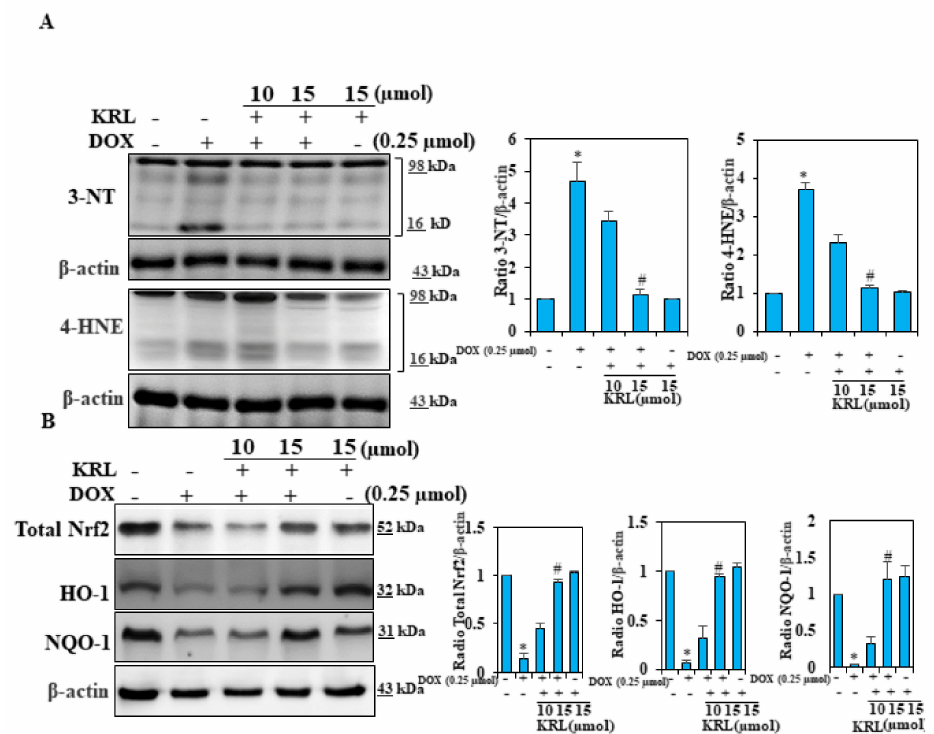
Figure 4. KRL prevents DOX-induced cardiac oxidative stress. ( A ) Cells were treated with KRL (15 µ mol) for 2 h prior to DOX (0.25 µ mol) stimulation for 24 h. Changes in 3-nitrotyrosine (3-NT) and 4-hydroxy-2-nonenal (4-HNE) protein levels of mitochondria were monitored by Western blotting. ( B ) The activation of total Nrf2, HO-1, and NQO-1 was examined by Western blotting. Data are represented as the mean ± SD of triplicate values ( n = 3) and * p < 0.05 represents significant variations compared with the control. # p < 0.05 represents significant variations as compared to DOX alone and KRL with DOX treatment